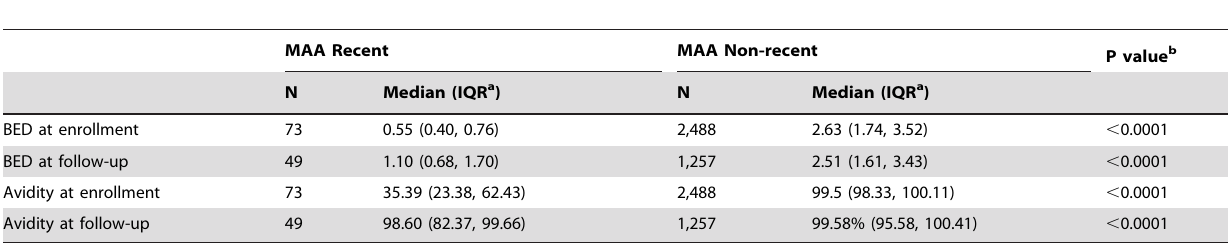
Table 1. Comparison of BED and avidity test results at enrollment and follow-up in women with MAA recent versus MAA non- recent HIV infection.*